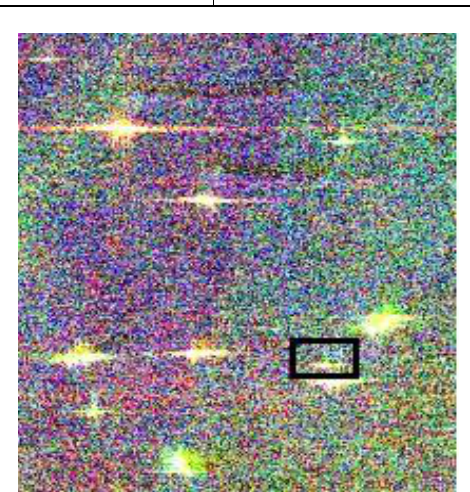
Fig. 3 ALOS PALSAR -1 sub-image A (size 235*207)